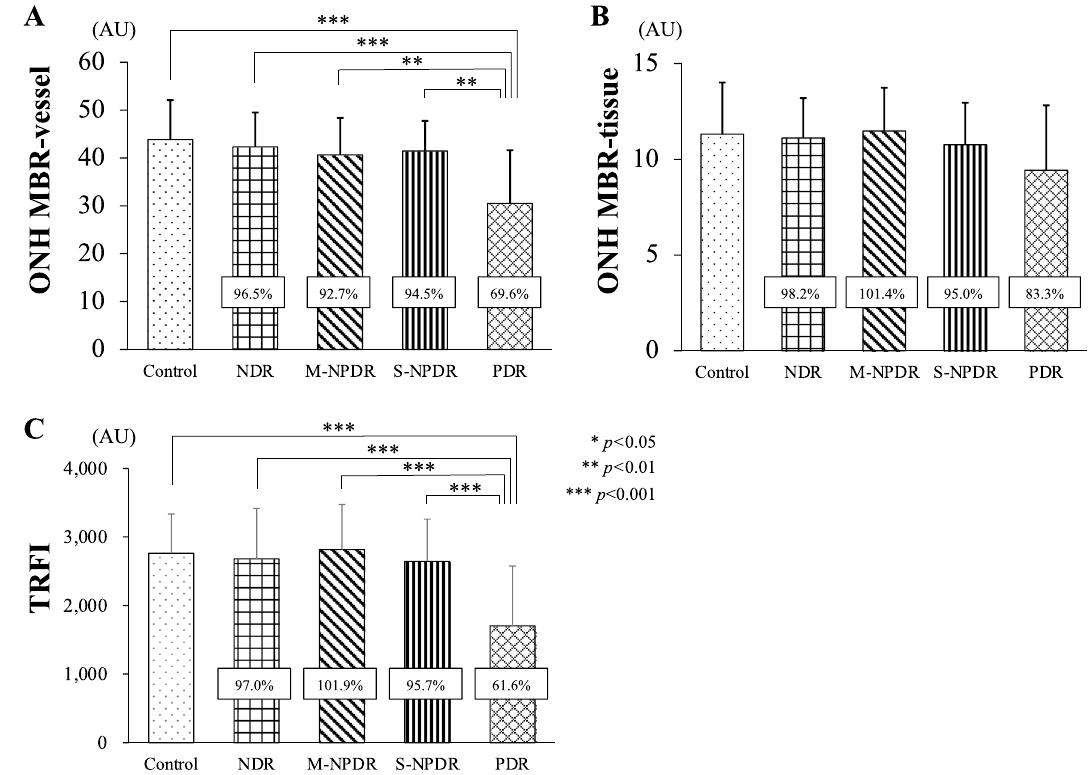
Figure 5. Differences in blood flow parameters determined by LSFG among the groups. The percentage differences are shown for four groups with diabetes and compared to the control group. The MBR of the vessels on the ONH in the PDR group is significantly lower than that in the other groups ( A ). There is no significant difference in the MBR-tissue among the groups ( B ). The total retinal flow index (TRFI) in the PDR group is significantly lower than the other groups ( C ).